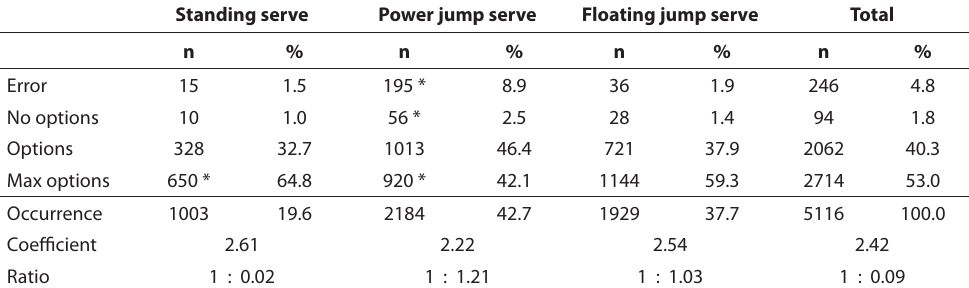
TABLE 2 Serve technique and reception efficacy in men’s beach